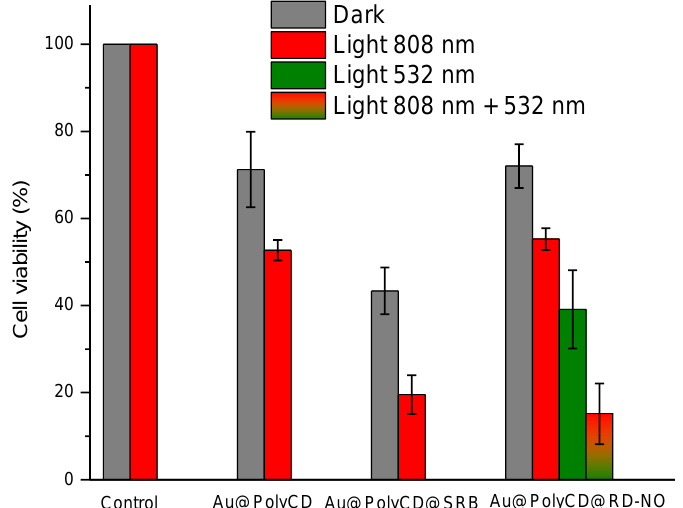
Figure 7. Cell viability observed 24 h after incubating HEP-G2 hepatocarcinoma cells with free aque-